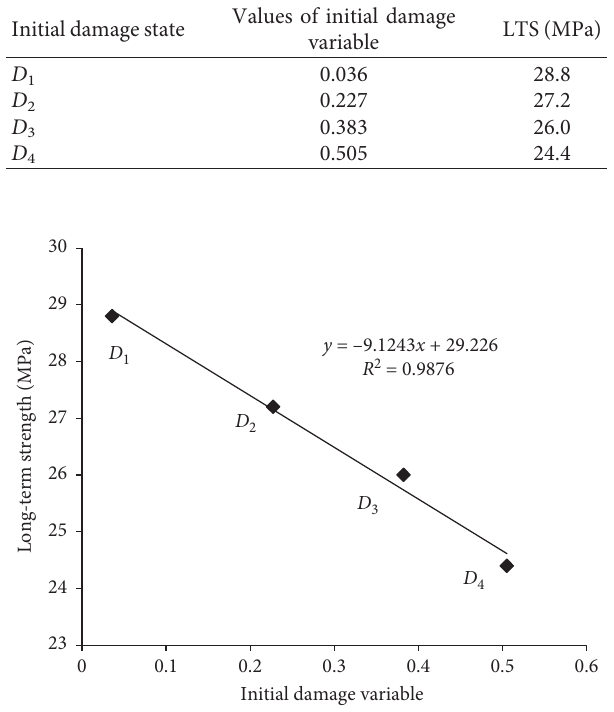
Table 3: LTS of rock specimens with different initial damage.